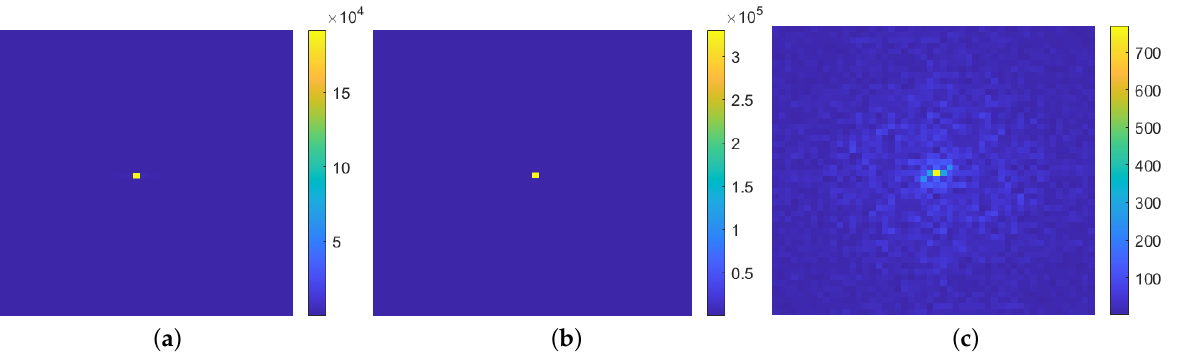
Figure 6. Power spectrum of spatial frequencies in three color channels of the microalgae image shown in Figure 1c. ( a ) Red channel; ( b ) green channel; ( c ) blue